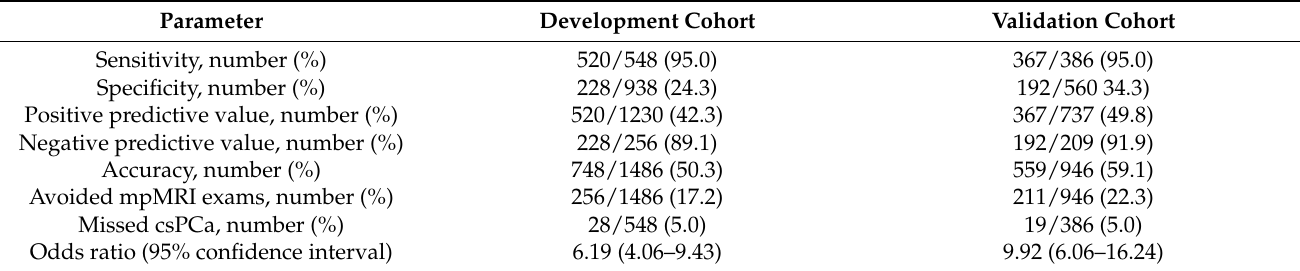
Table 4. Performance of developed predictive model of csPCa in development and validation cohorts from the 95% sensitivity threshold of csPCa of the development cohort.